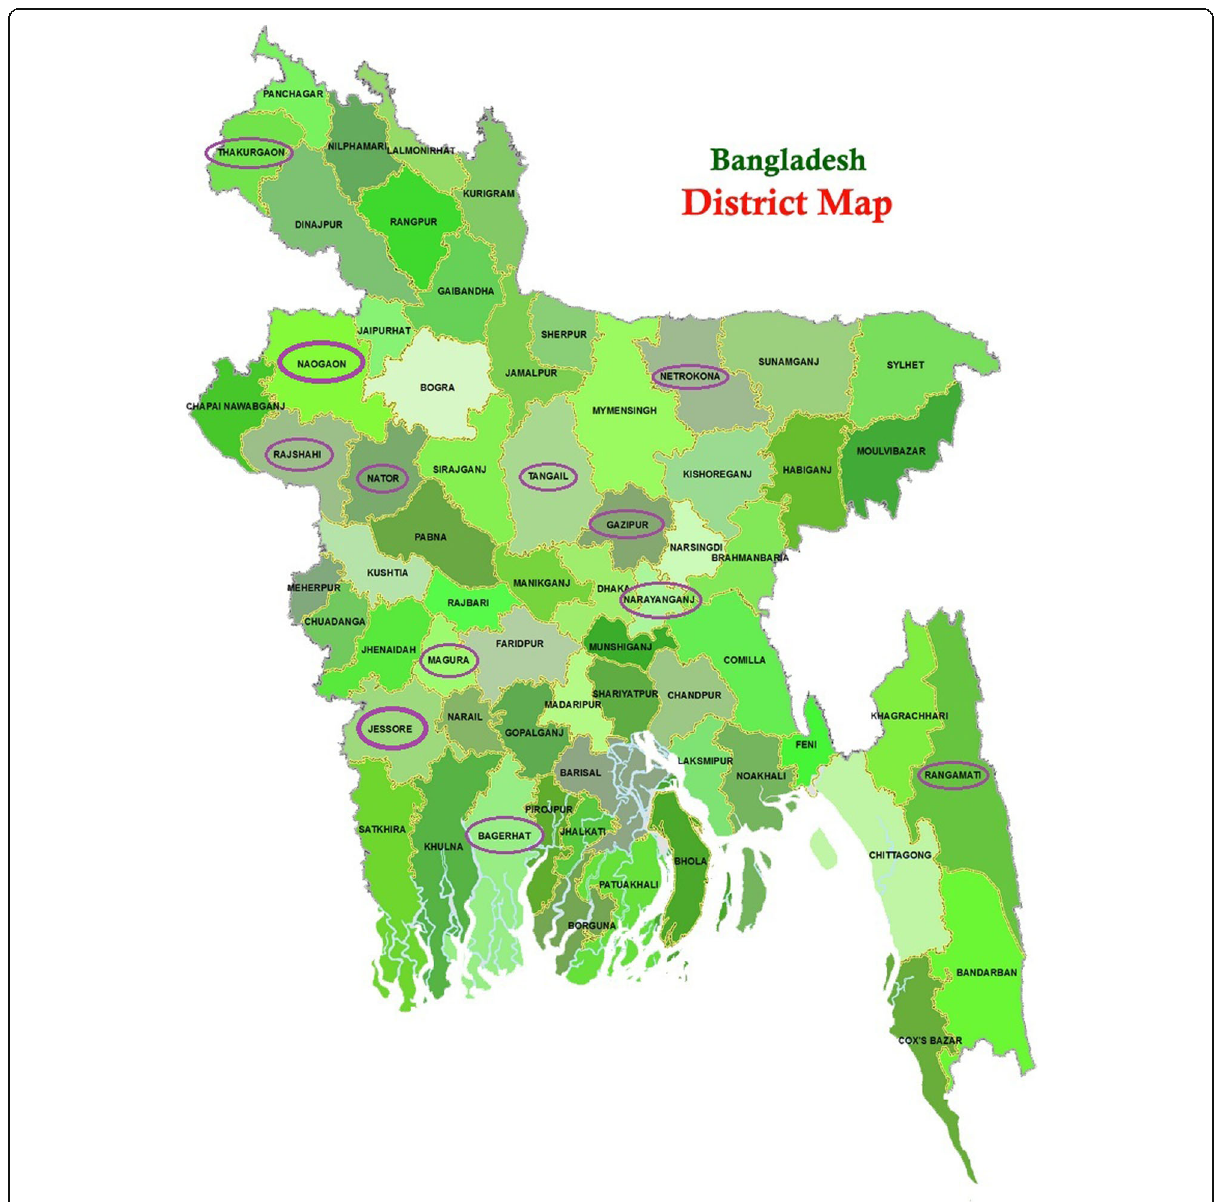
Fig. 1 District map of Bangladesh. Circles showing the name of the informed districts from where the survey was conducted by authors. Map source: PNGWING